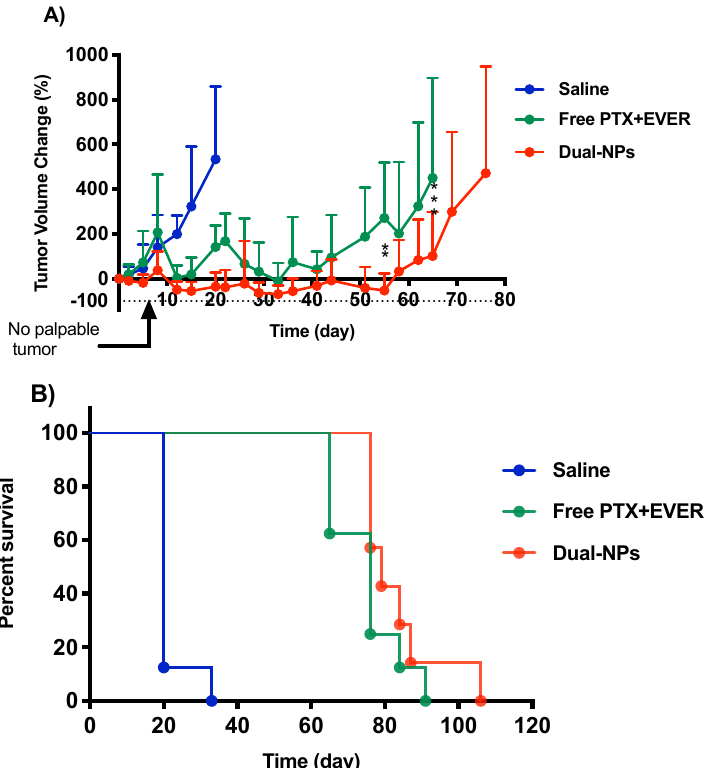
Figure 3. ( A ) Tumor growth inhibition of saline (blue), free paclitaxel and everolimus (PTX+EVER) (green), and dual-targeted PTX+EVER-loaded nanoparticles (Dual-NPs) (red) in female NOD/SCID mice bearing MDA-MB-231-H2N BC xenografts (HER2 mod /EGFR mod ) after intravenous administration of treatments at a PTX-equivalent dose of 15 mg/kg and EVER-equivalent dose of 7.5 mg/kg once a week for eight consecutive weeks. Data represent mean ± SD ( n = 8). Two-way analysis of variance (ANOVA) was conducted where ** and *** indicate p = 0.001 and p = 0.0003, respectively. ( B ) Kaplan-Meier survival analysis.